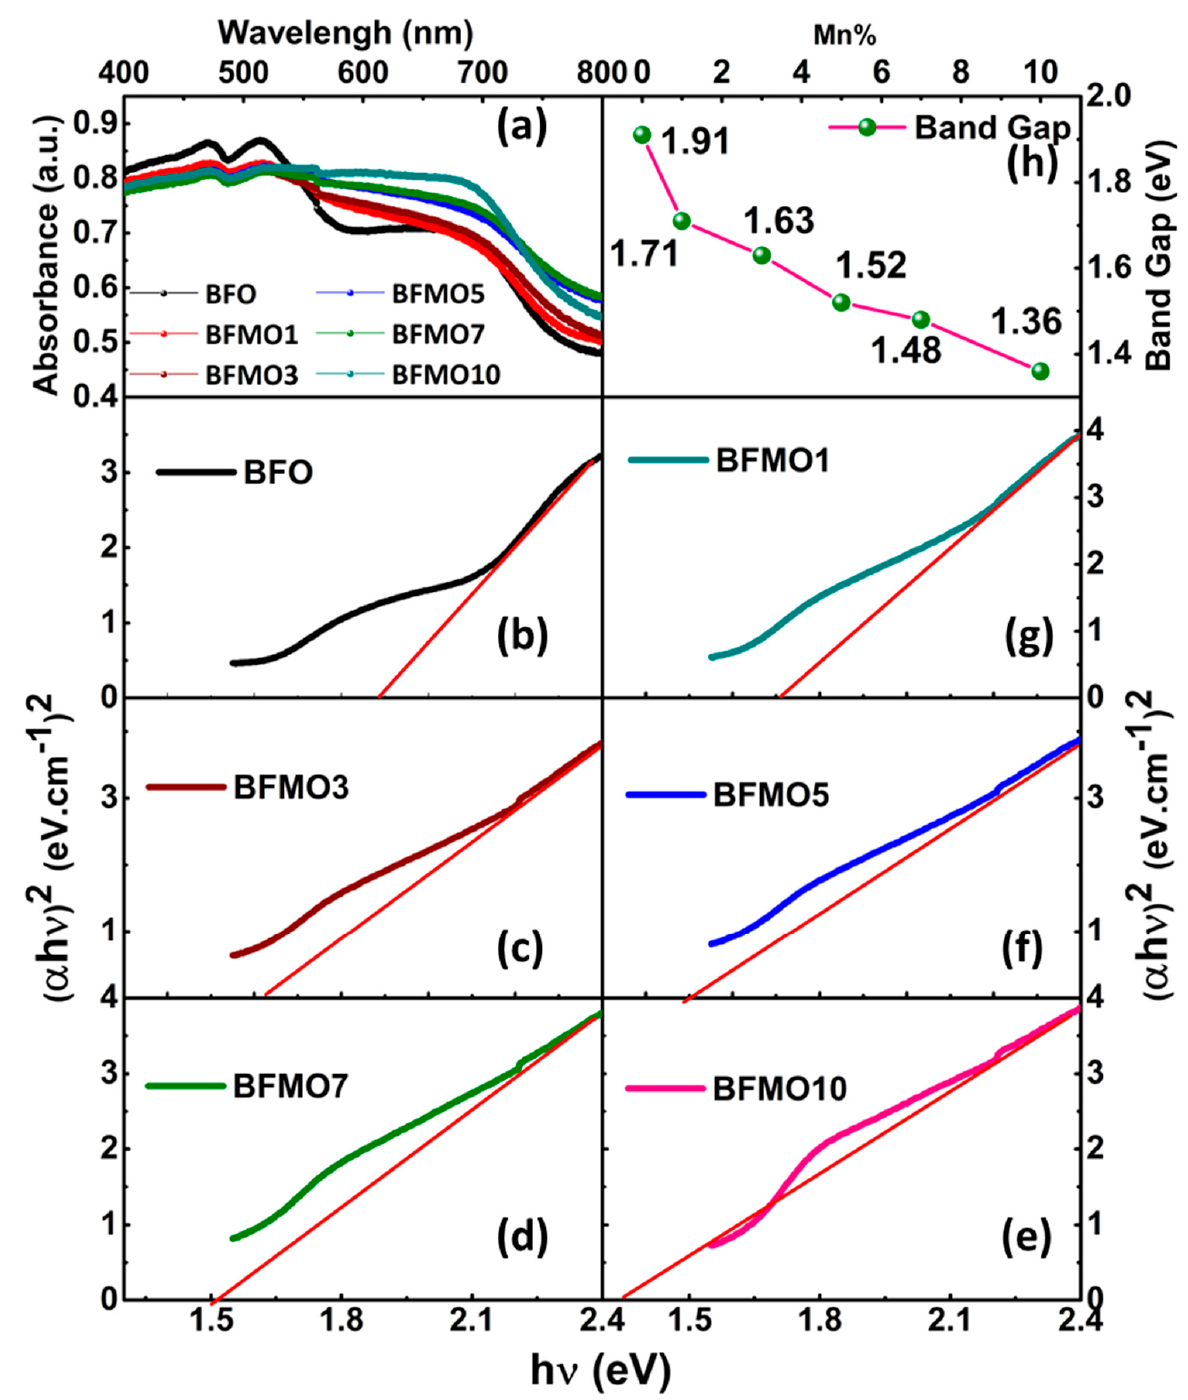
Figure 6. ( a ) UV-vis absorption spectra; ( b – g ) Tauc’s plots indicating interpolated fitted linear region; and ( h ) band gaps as a function of Mn concentration.